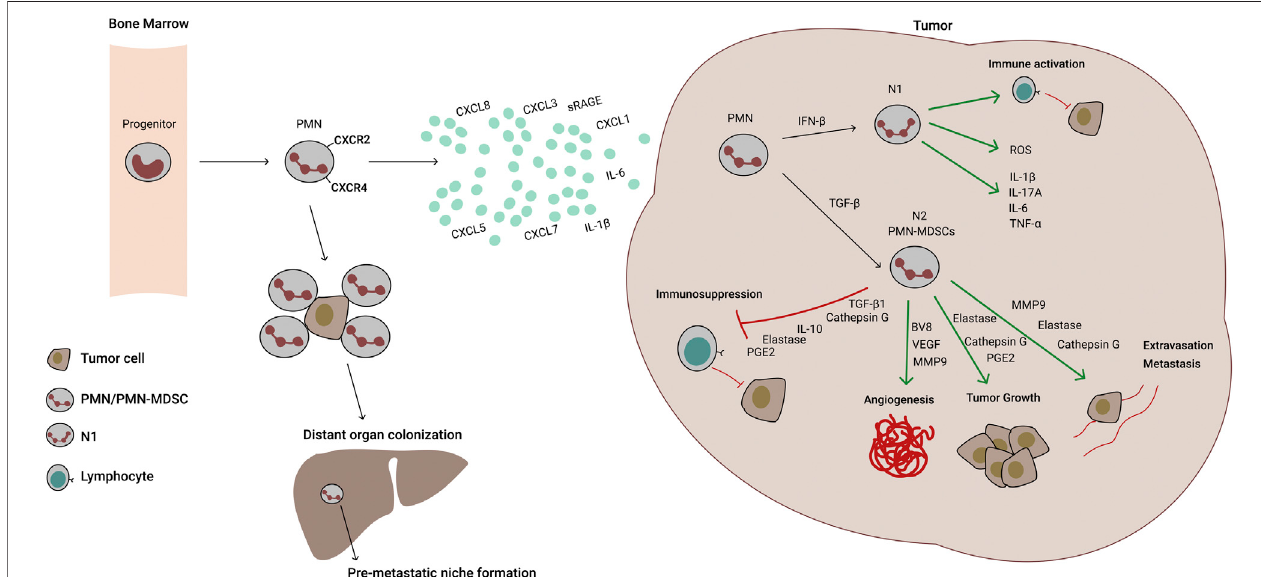
FIGURE 1 | Molecular mechanisms of neutrophil recruitment and activity in lung cancer. Polymorphonuclear (PMN) progenitors mature to PMN cells and exit the bone marrow through CXCR2 sensing of tumor secreted chemokines and cytokines (IL-8/CXCL8, CXCL1, -3, -5, -7, IL-6 and IL-1 β ). Once in the tumor, PMNs can differentiateintoN1orN2tumor-associated neutrophils(TANs).N1TANsarepro-in fl ammatory,havehighexpression oftheantigen-presentingmachineryandReactive OxygenSpecies(ROS)production,butlowarginase-1activity.Throughantigenpresentationandin fl ammatorycytokinesecretion,theystimulateanti-tumorTcells and exert direct killing of tumor cells mediated by ROS and nitric oxide (NO) production. Under TGF- β induction, however, PMN differentiate into N2 TANs or PMN- MDSCs, which are less mature, immunosuppressive and foster angiogenesis, tumor growth and metastasis. In contrast to N1 TANs, N2 TANs cells downregulate antigen presentation, but express high levels of PD-L1, arginase-1, ROS and NO. Additionally, they produce crucial soluble mediators of neovascularization, tumor cell growth, extravasation and metastasis. Additionally, CXCR2/4 signaling recruits PMNs to seeding organs promoting pre-metastatic niche formation. PMNs are able to protect CTCs (circulating tumor cells) and escort them to distant organs, improving metastatic